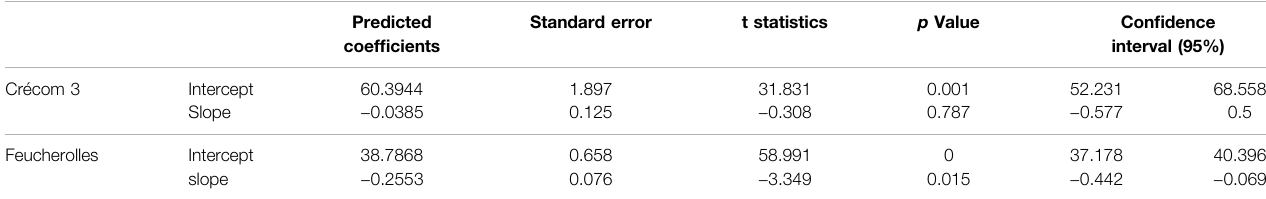
TABLE 3 | Predicted coef fi cients of the linear regressions of soil organic carbon (SOC) stock changes with time, for the Crécom 3 (0 – 30 cm) and Feucherolles (0 – 29 cm) control